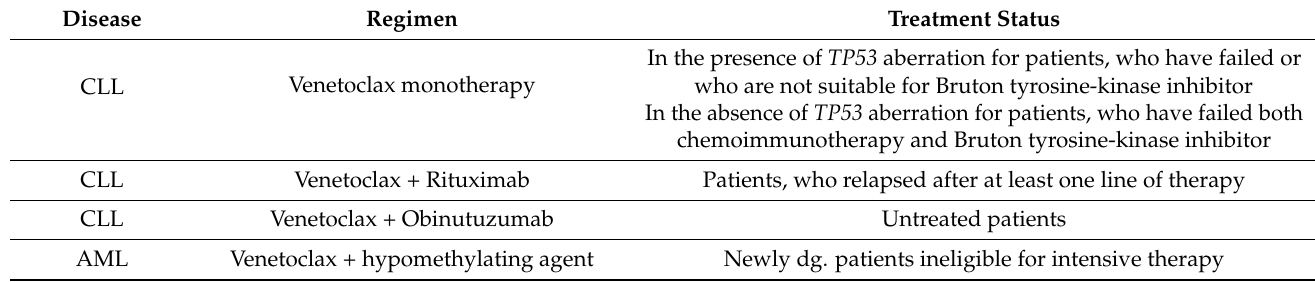
Table 3. Clinically approved indications of